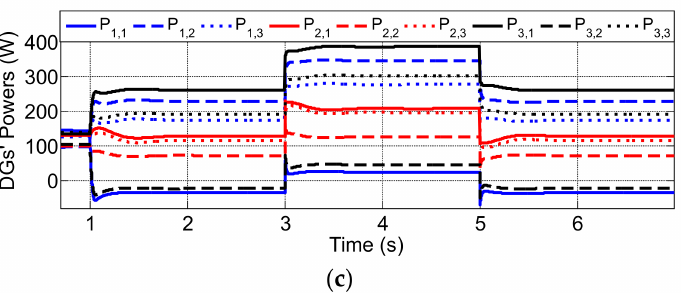
Figure 6. Linear consensus control system: ( a ) DGs’ incremental costs, ( b ) MGs’ voltages, and ( c ) DGs’ generations.